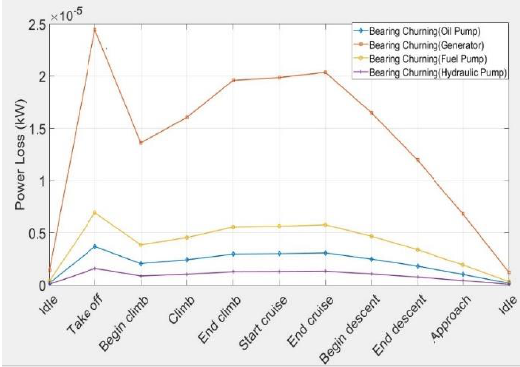
Figure 6. Power losses due to bearing churning.